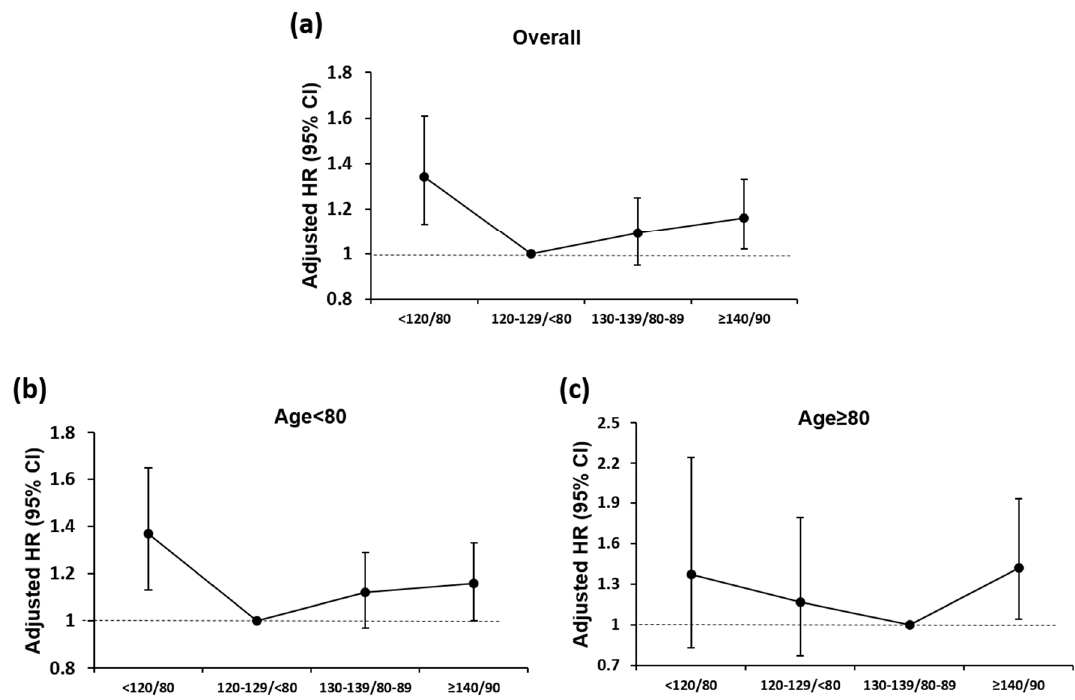
Figure 5. Blood pressure status of repeated measurement and risk of atrial fibrillation among elderly populations with antihypertensive medications: ( a ) overall population, ( b ) age < 80 years, and ( c ) age ≥ 80 years.